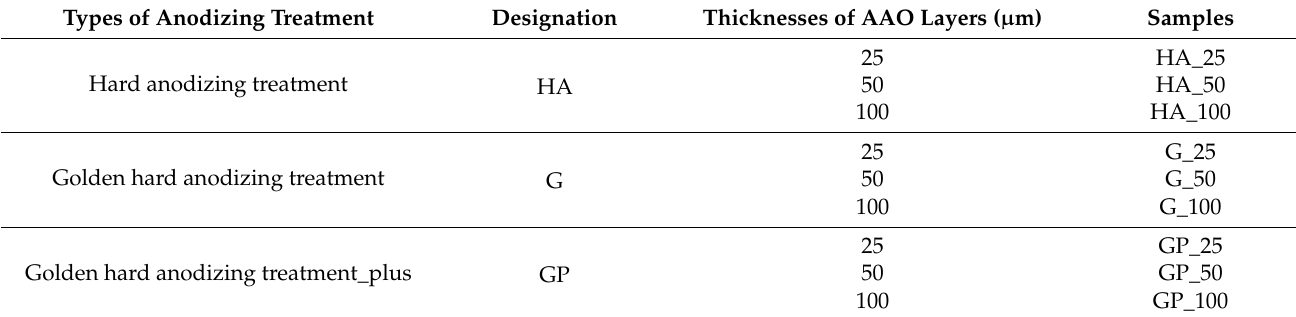
Table 1. Summary of the samples, together with information on the types of anodizing treatment, their designation, and thicknesses of AAO